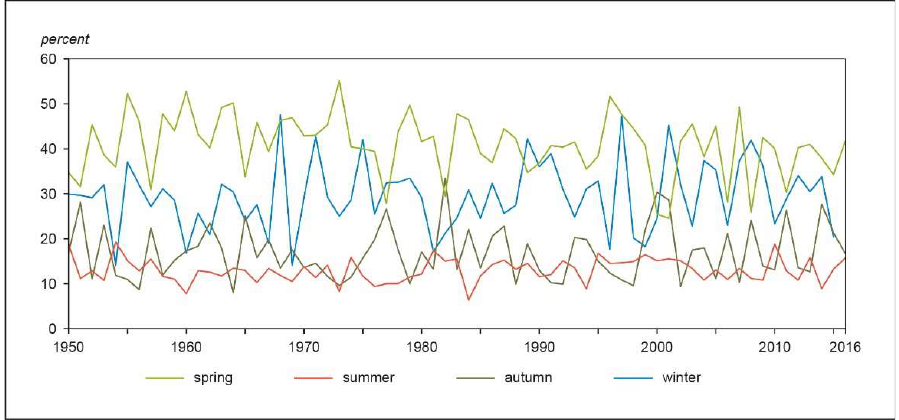
Figure 7. Seasonal proportions of annual precipitation sums in the research area from 1950 to 2016